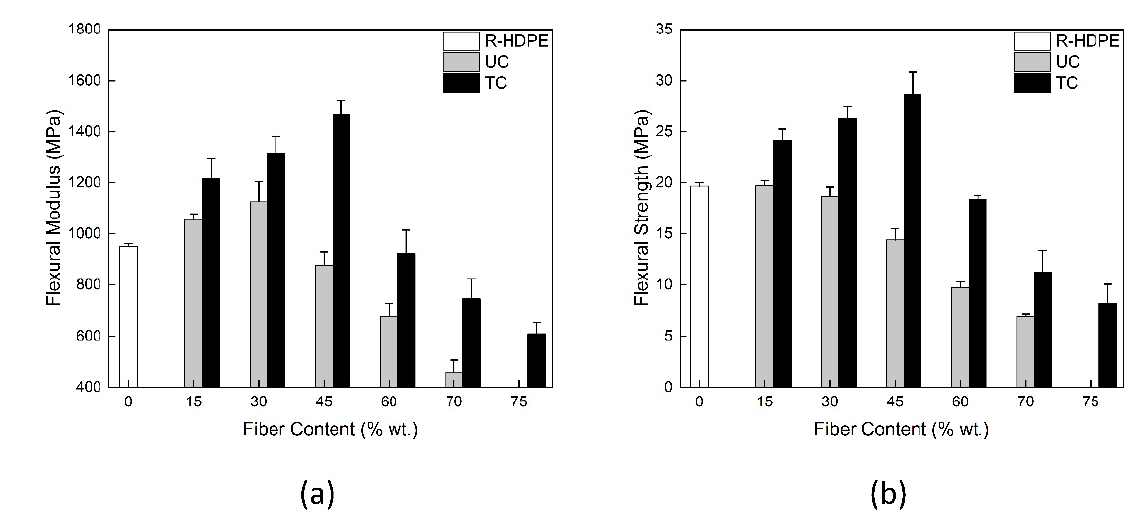
Figure 13. Flexural modulus ( a ) and flexural strength ( b ) for recycled high-density polyethylene (R-HDPE), untreated (UC) and treated (TC) composites as a function of fiber content.